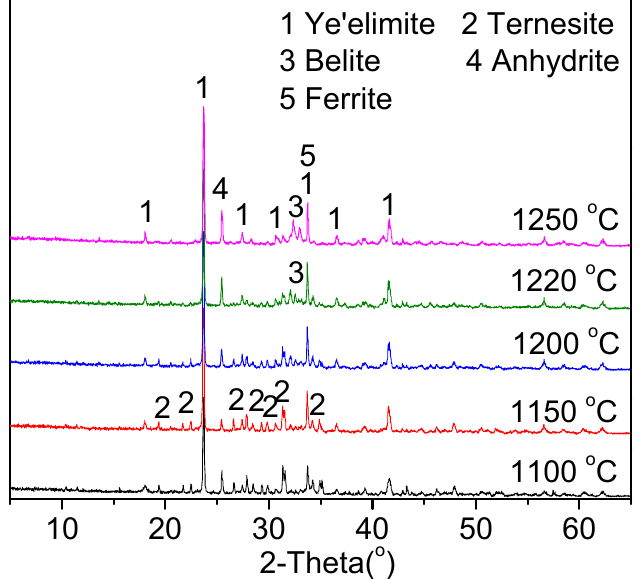
Figure 4. XRD patterns of cement clinker B burned at different temperatures for 30 min.